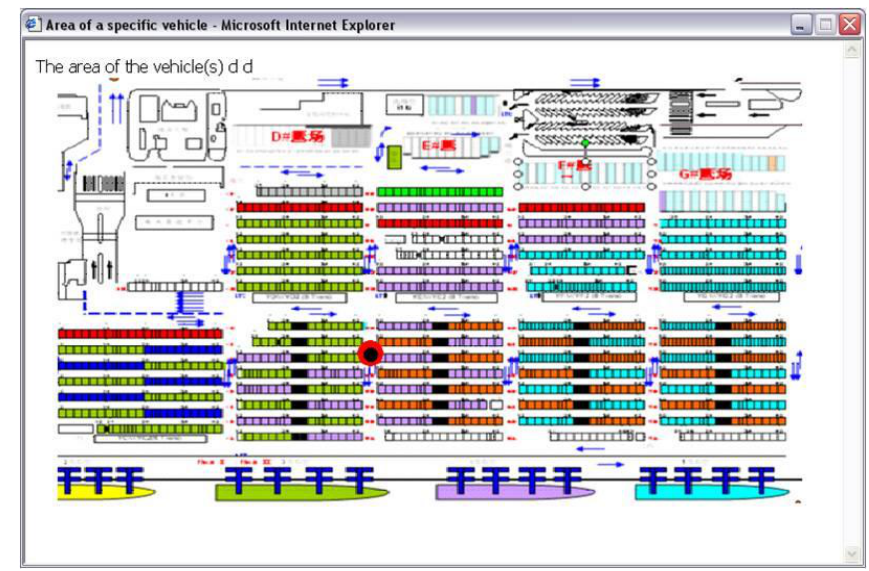
Figure 8. Interface for vehicle location